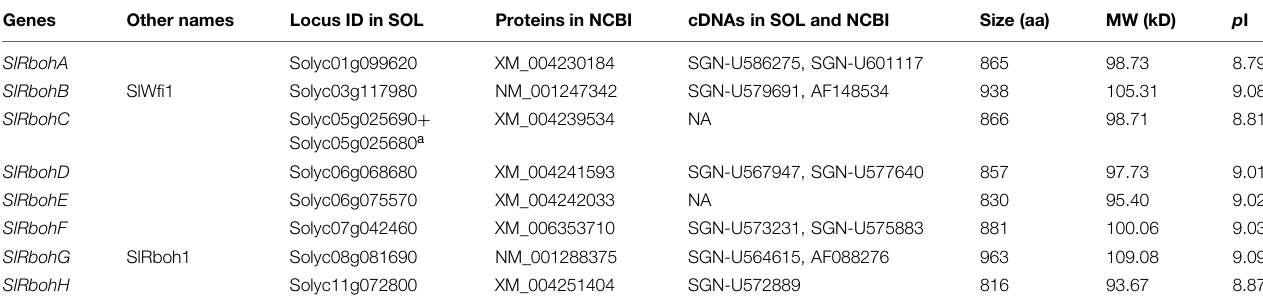
TABLE 1 | Characterization of tomato NADPH oxidase genes.